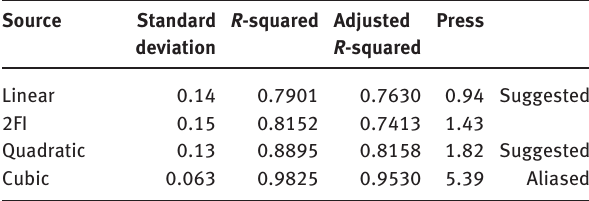
Table 6: Model summary statistics for the distortion model.